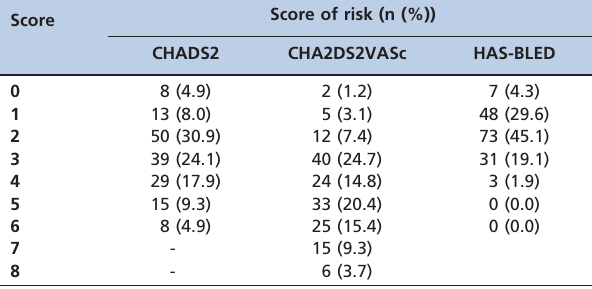
Table 2 - Distribution of patients according to their CHADS2, CHA2DS2VASc and HAS-BLED scores.